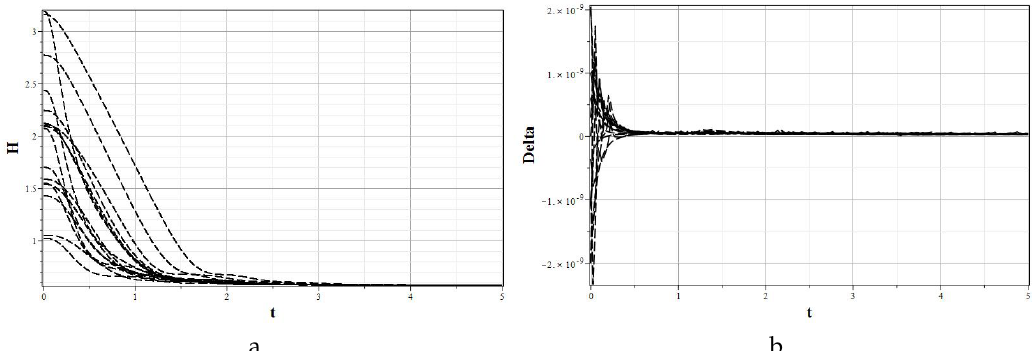
Figure 3. Dependence of H on t ( a ); deviation of the integral of motion ∆ ( t ) from zero ( b